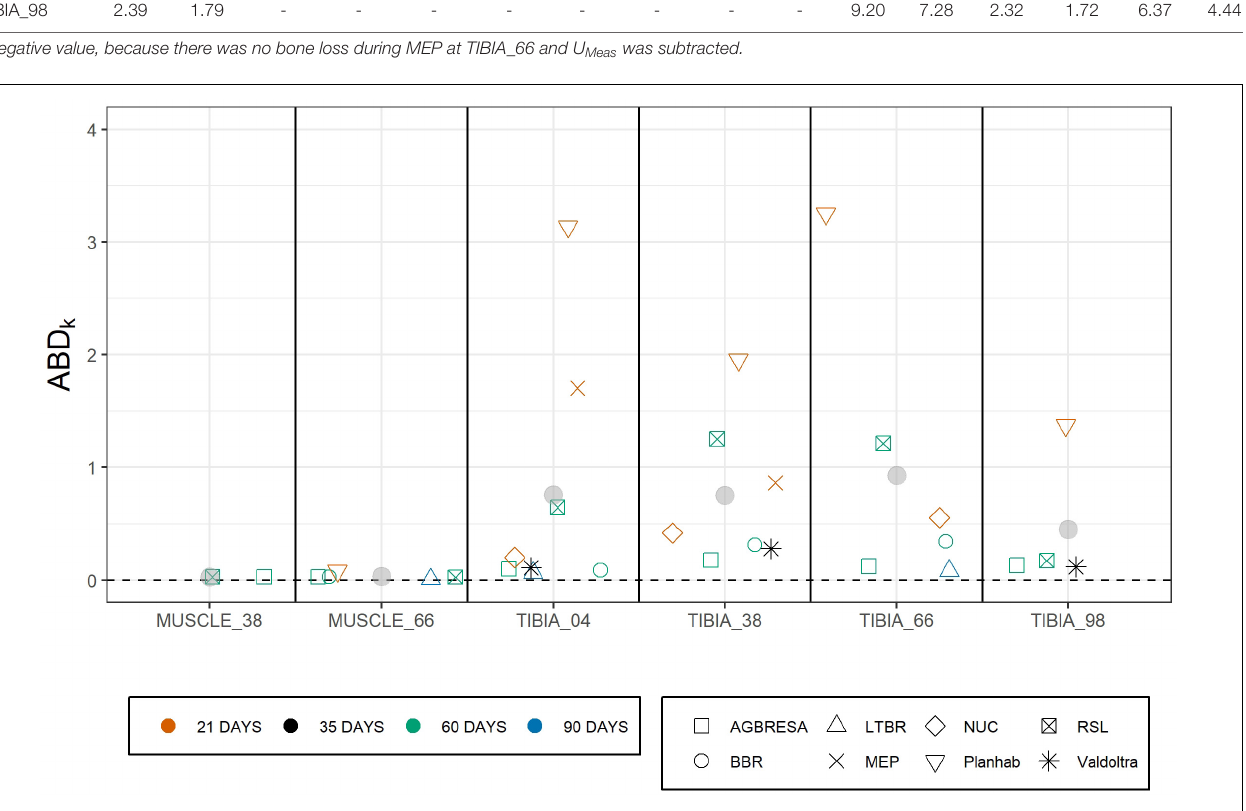
FIGURE 4 | Adjusted between subject deviation (ABD k ) of all studies separated by measurement sites. ABD k represented the square root of uncertainty of individual response U IR divided by pc k enabling the comparison of several studies with different bed rest durations. The color indicates the bed rest duration and the shape represents the study. The data of MEP for TIBIA_66 are missing due to negative values of the uncertainty of individual response U IR . Gray points represent the mean value of the specific measurement